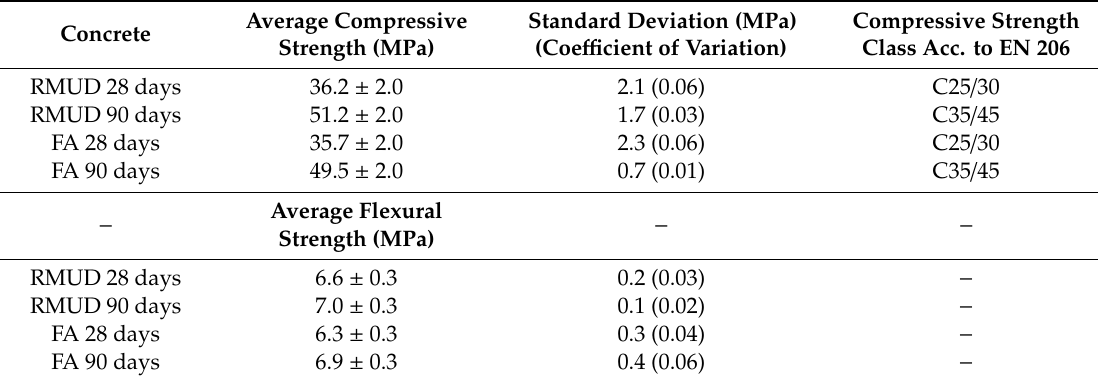
Table 5. Compressive strength of